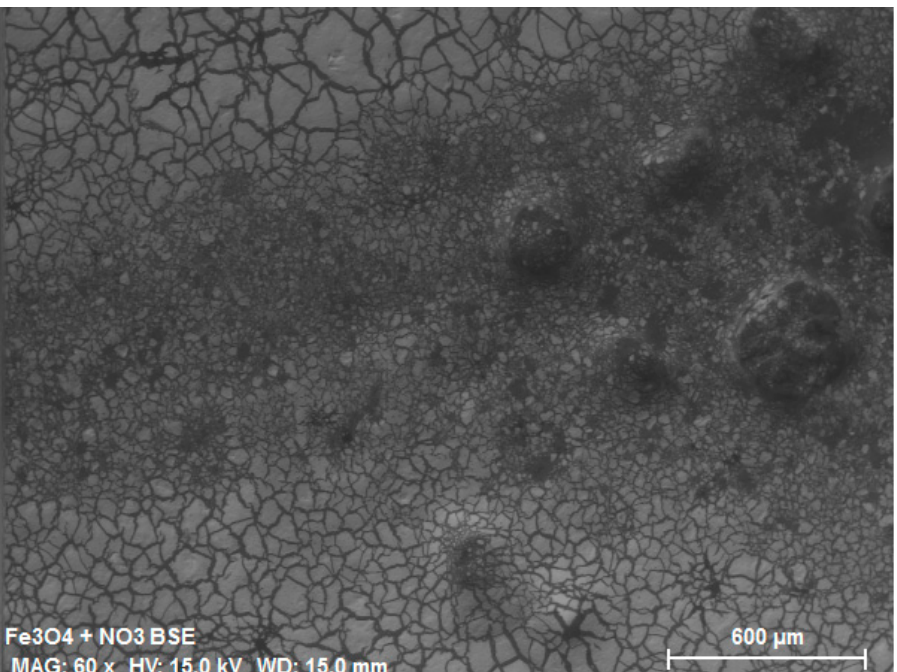
Figure 4. SEM image for Fe 3 O 4 @AgNPs after the adsorption. Darker structures are associated to the presence of nitrates, due to the lower atomic number of N.